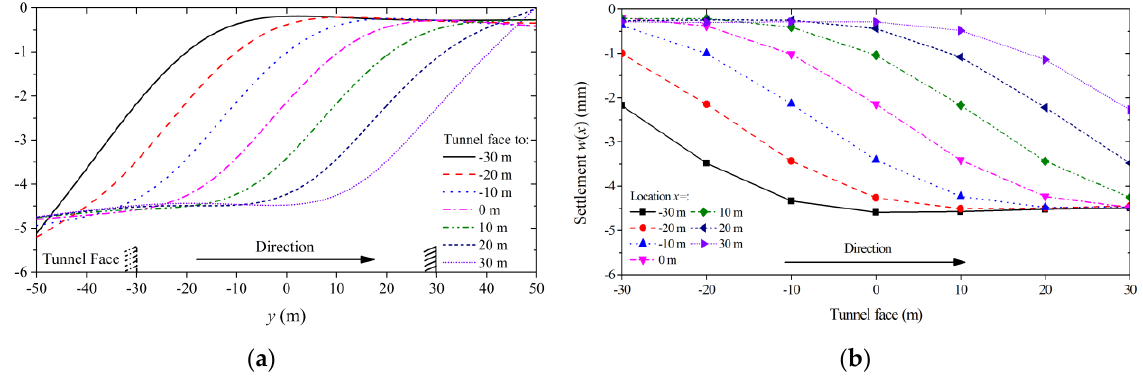
Figure 18. Existing pipeline’s deformation contours extracted from front view and side view: ( a ) Longitudinal Deformation Curve (LDC) extracted from front view; ( b ) deformation development curve (DDC) extracted from side view.